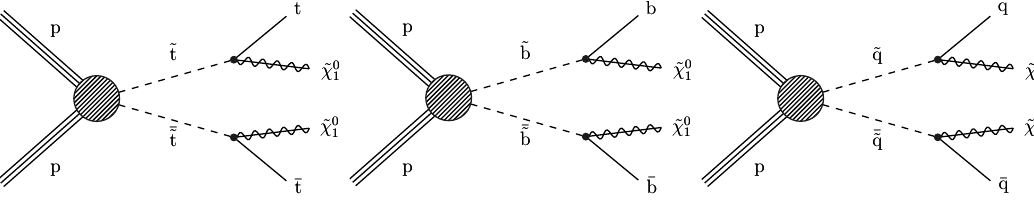
Figure 1 . Diagrams for the simpli(cid:12)ed models with direct gluino pair production considered in this study: (upper left) T1tttt, (upper right) T1bbbb, (lower left) T1qqqq, and (lower right) T5qqqqVV.